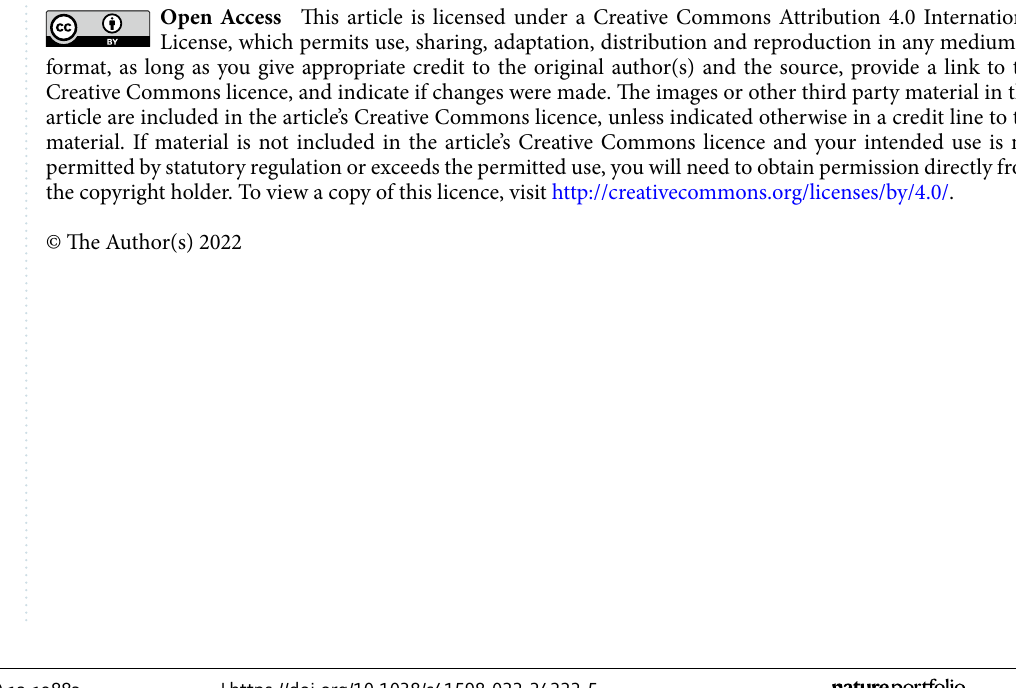
“ Figure 3 . S. exempta future environmental suitability maps for Kenya and Tanzania for 3 different CO 2 emission scenarios. ( A ) 2061-2080 SSP1-2.6, ( B ) 2061-2080 SSP3-7.0, and ( C ) 2061-2080 SSP5-8.5.” The original Article has been